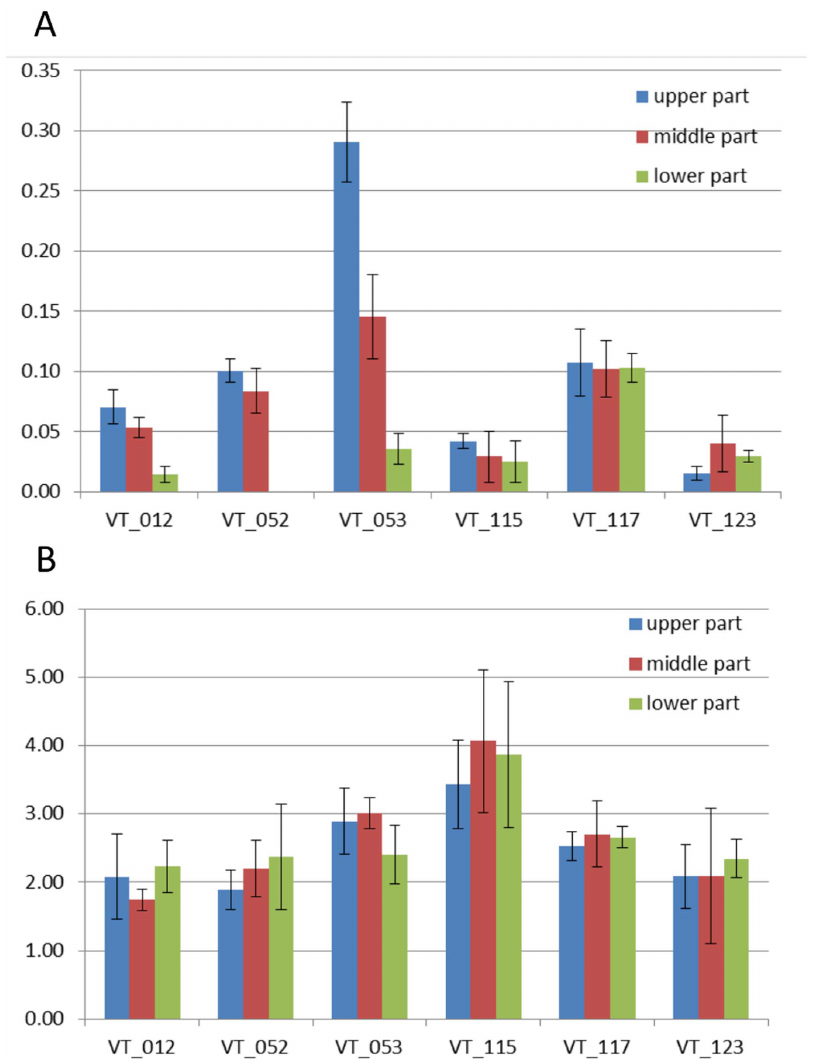
Figure 2. Comparison of lignification ratio (darker stained proportions in the wood cylinder) (A) and xylem/phloem ratio (B) for the six turnip accessions. Error bars stand for standard deviation.